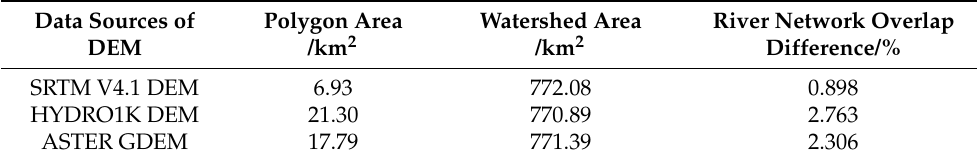
Table 4. Results of river network ensemble difference for three kinds of DEM data sources.